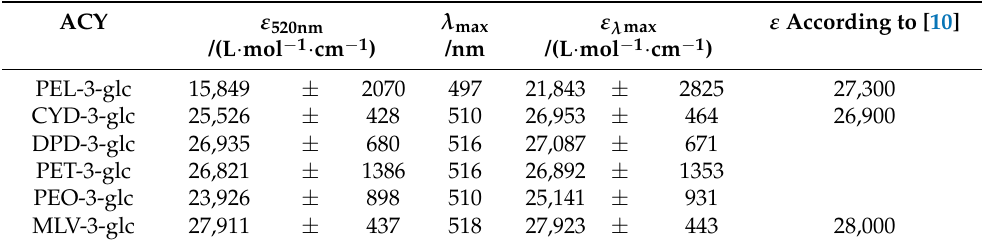
Table 3. Absorption coefficients for different anthocyanins in potassium chloride buffer at pH 1 at 520 nm and λ max using concentrations determined by balance.